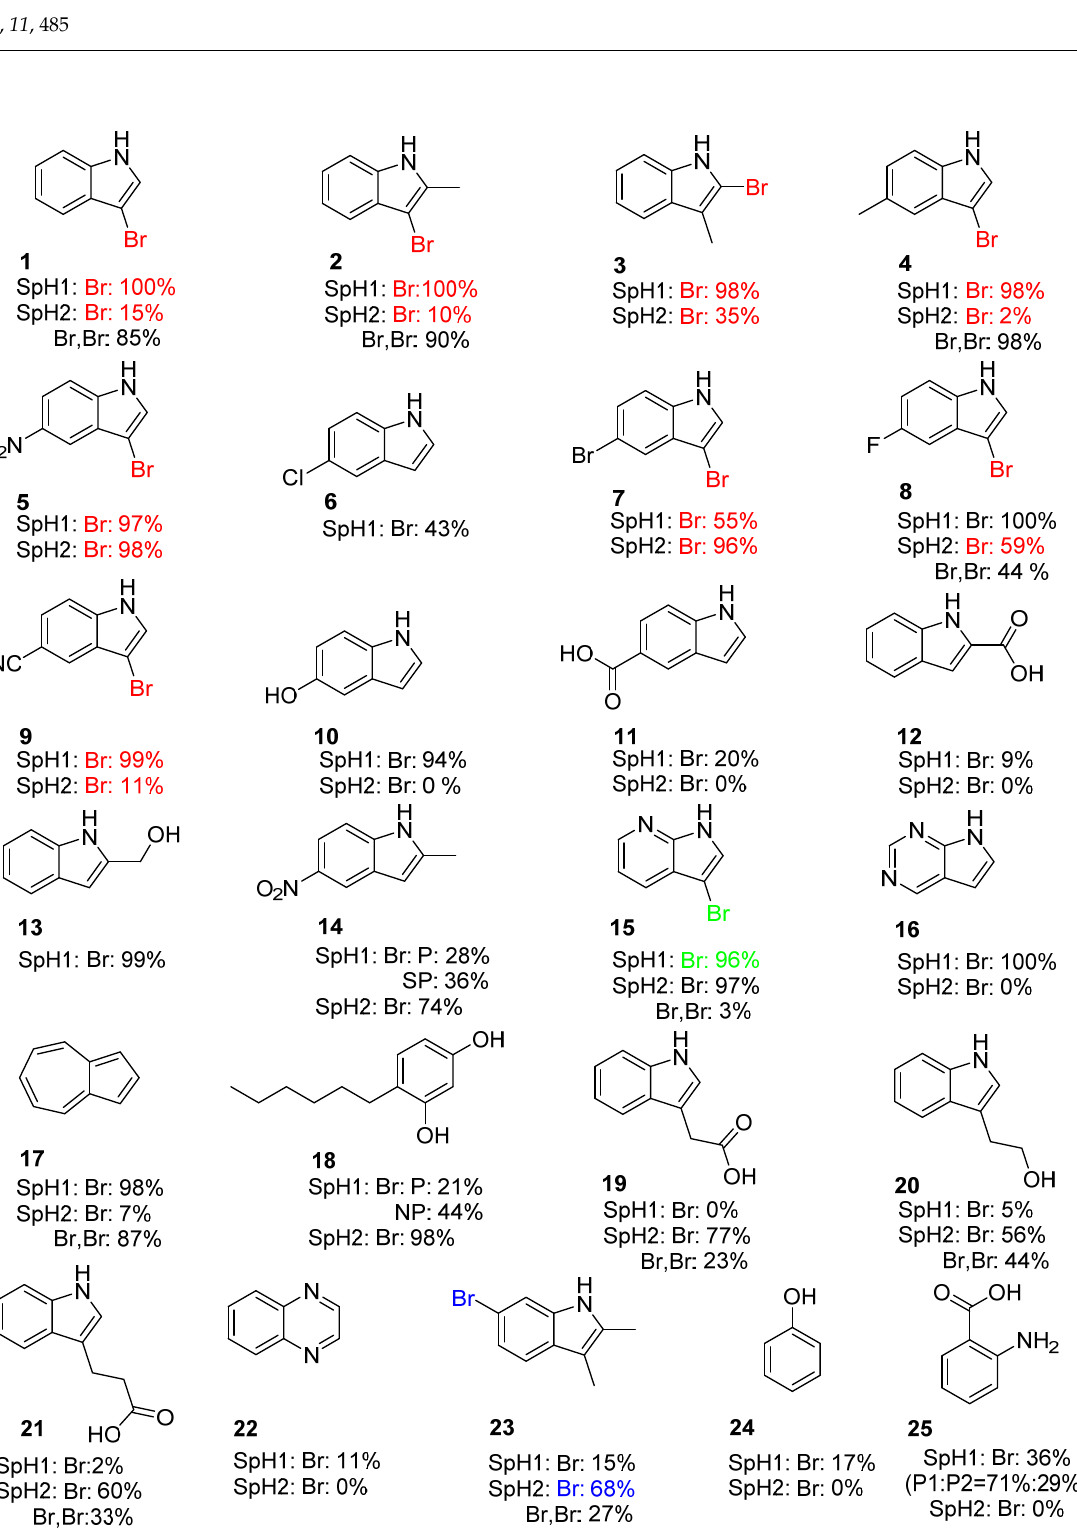
Figure 4. Halogenated substrates by SpH1 and SpH2. The conversions were calculated by determining the ratio of the peak areas of substrates and products. The position of halogenation was determined for 10 substrates by NMR analysis (red: SpH1 and SpH2, green: SpH1, and blue: SpH2). SP: different unidentified side products; P1, P2: two monobrominated products at a ratio of P1/P2.; NP: side product.